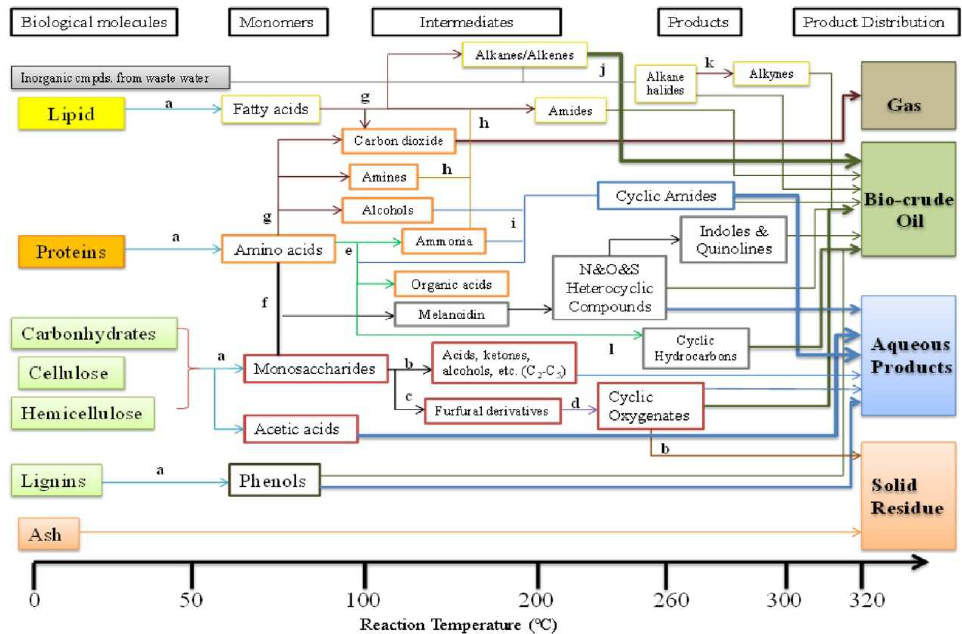
Figure 5. Hydrothermal reaction path of raw material components.: ( a ) hydrolysis; ( b ) decomposi- tion; ( c ) dehydration; ( d ) polymerization; ( e) deamination; ( f ) Maillard reaction; ( g ) decarboxylation; ( h ) aminolysis; ( i ) cyclization; ( j ) halogenations; ( k ) dehydrohalogenation; ( l ) condensation + pyrol- ysis. Reprinted from [98] with permission from Elsevier.